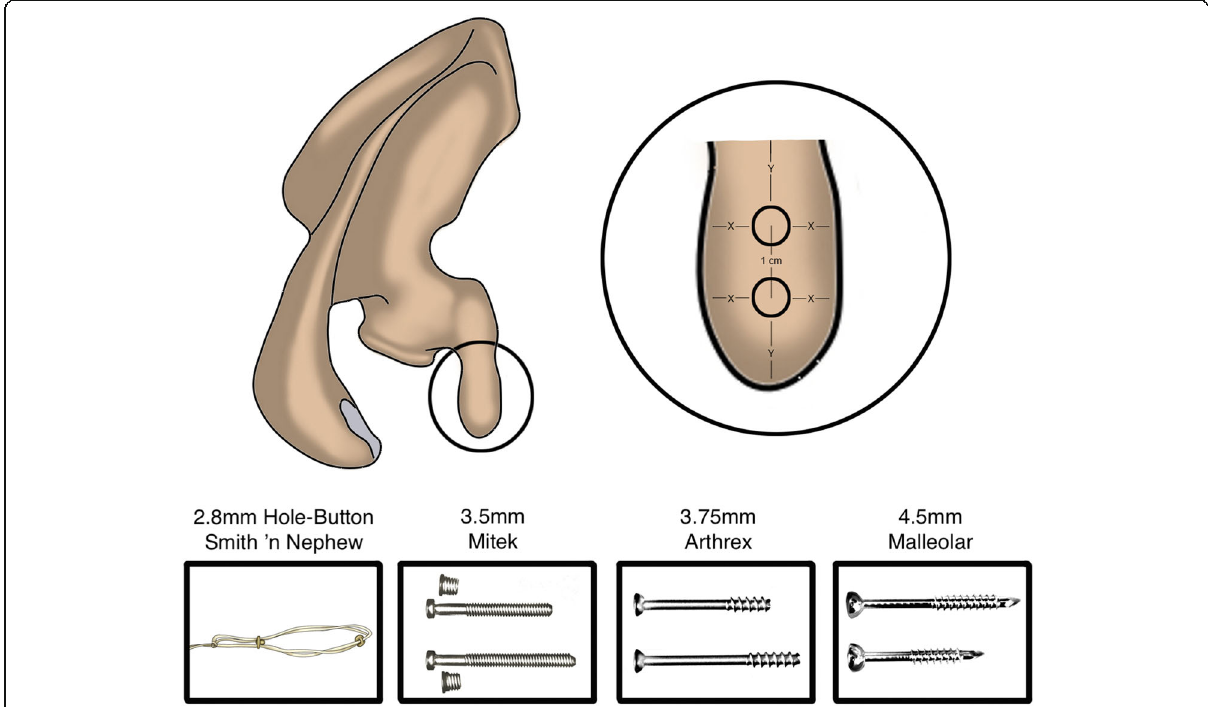
Fig. 4 Art design showing the harvested coracoid graft. The distance from the center of the two holes was set at 10 mm. Y = Distance from the Supero-Inferior Limit. X = Distance from the Medio-Lateral Limit. Also are shown the four common surgical fixation techniques for the Latarjet procedure